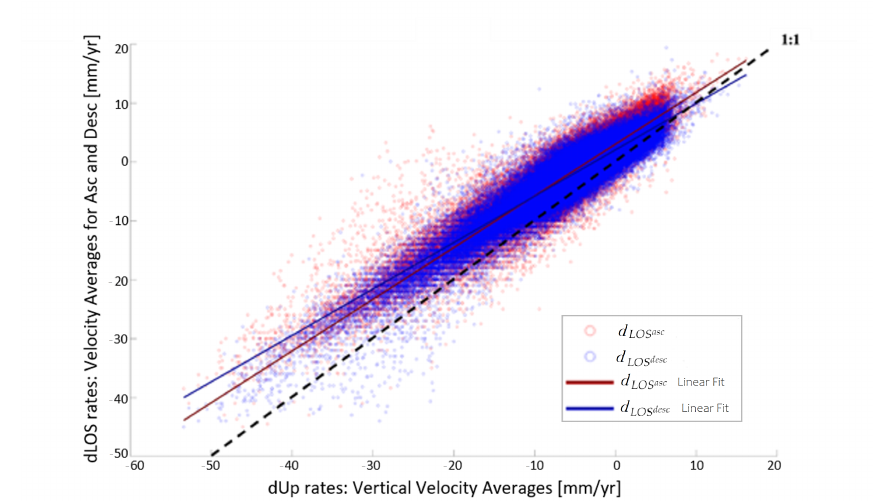
Figure 5. Scatterplot of LOS (asc and dec) subsidence and vertical subsidence. A one-to-one ratio is depicted as the black dashed line for relative measure, demonstrating the increasing influence of geometric correction with higher rates of